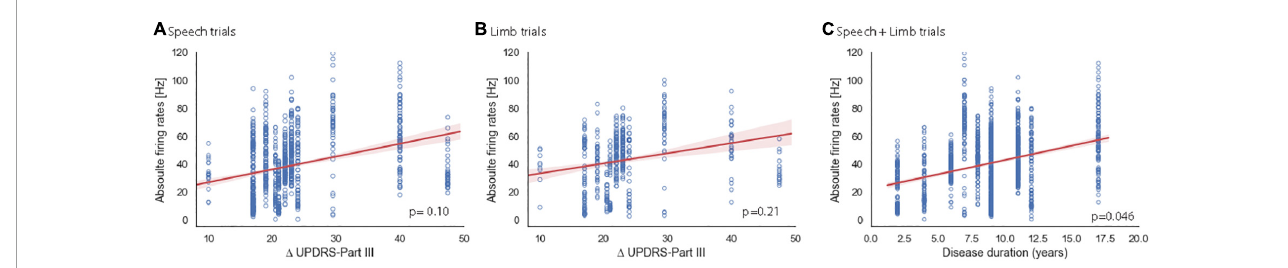
FIGURE5 Relationship of sensitivity to dopaminergic replacement (A,B) and PD duration (C) to single unit STN firing rates. Red shaded areas illustrate the 95% confidence interval of regression analysis. Change in pre-operative total UPDRS III score in the OFF vs. ON PD medication state for speech (A) and limb (B) trials. Note that two participants had the same (cid:49) UPDRS III total and are overlapping in panels (A,B) at 22 (s261, s270). (C) PD duration showed a significant correlation with single-trial firing rate for speech and limb trials. Note that two pairs of subjects have the same PD durations and are overlapping in this plot at 6 years (s265, s270) and at 11 years (s277,